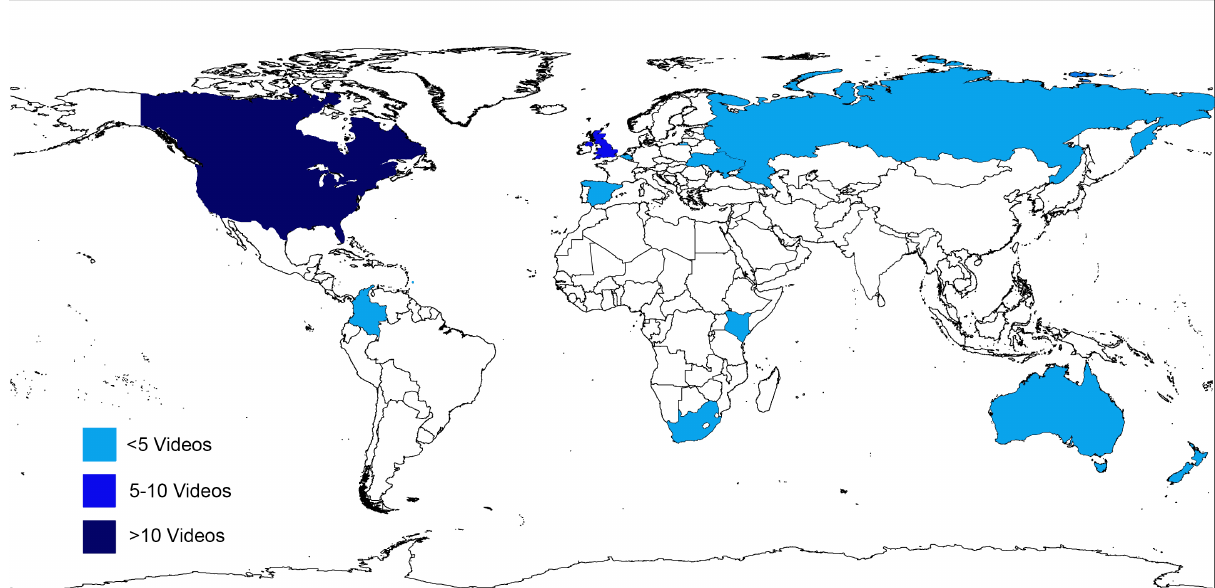
Figure 2. Global distribution of search results.